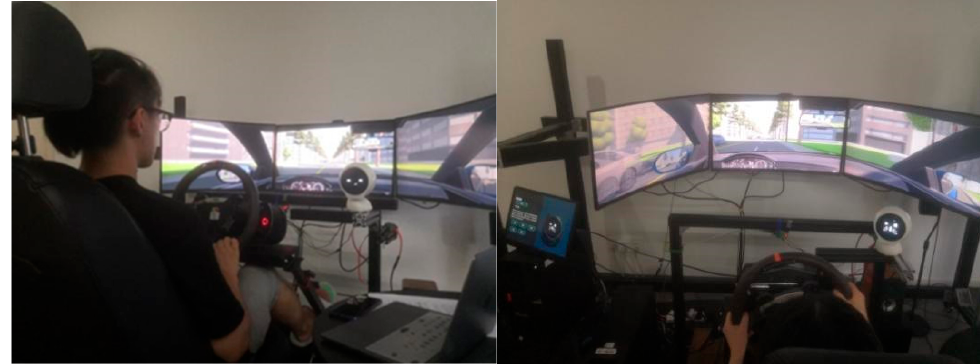
Figure 5. Experiment environment.